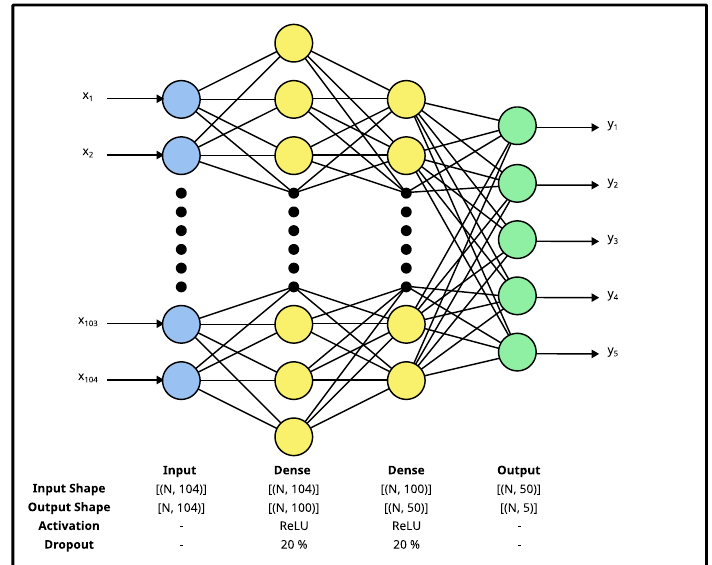
Figure 5. MLP classifier’s architecture. The network consists of six layers: an input dense layer, two dense + dropout blocks, and a dense output layer. The input layer has 104 neurons, the first hidden layer has 100 neurons, the second layer has 50 neurons, and the output layer has 5 neurons. A dropout rate of 20% was used for each dropout layer. The network takes a 1 × 104 vector (x 1 –x 104 ) and produces a 1 × 5 vector (y 1 –y 5 ). The network’s architecture was experimentally determined using a grid-search-based approach.